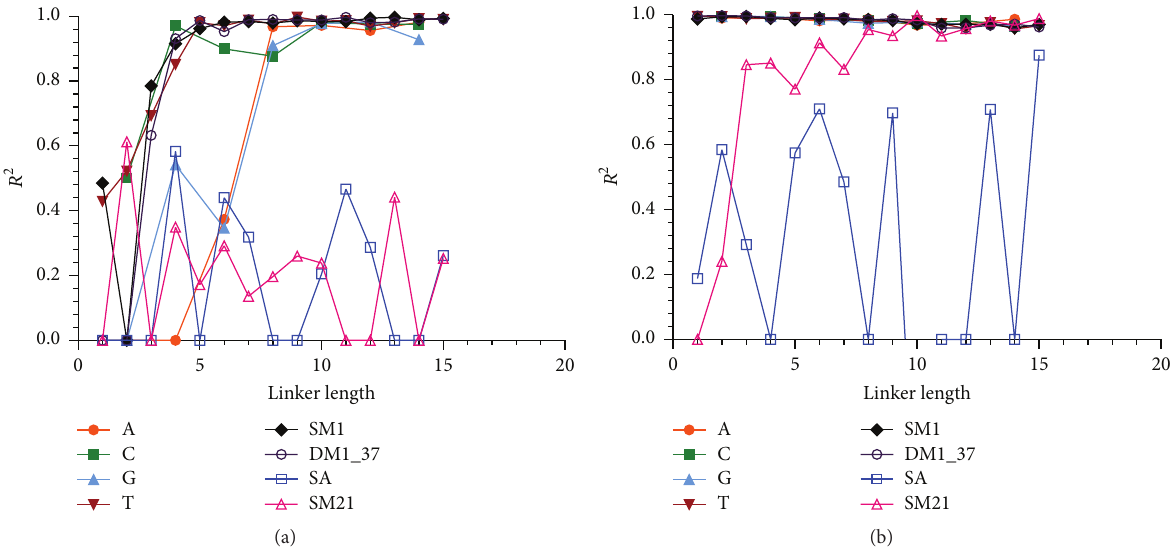
Figure4:Comparisonofcoefficientofdetermination( 𝑅 2 )versuslinkerlengthfor(a)directlabelingmethodand(b)indirectlabelingmethod. CurveswerefittoaonesitespecificbindingwithHillslopemodelusingGraphPadPrism.A(circle),C(square),G(triangle),andT(downward triangle) are the linkers used for IgE 17-4 aptamer. The remaining sequences (SM1, DM1 37, SA, and SM21) all possessed T